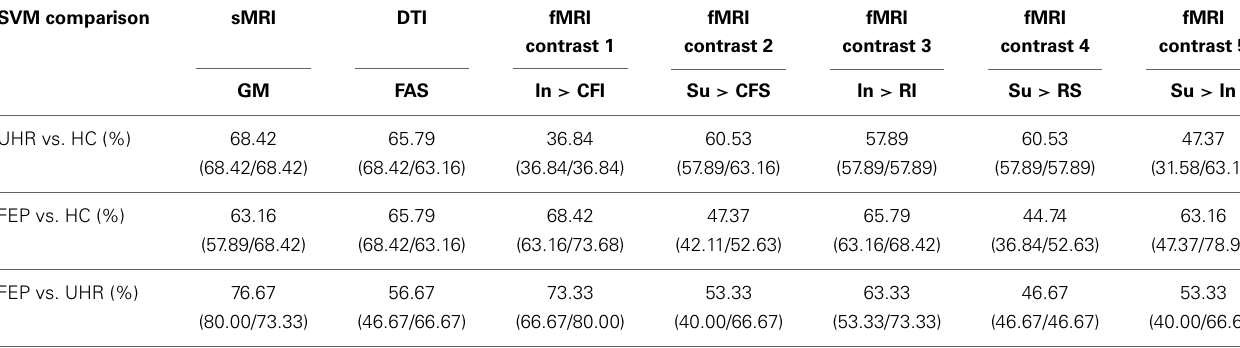
Table 1 | SVM classification accuracies using single modality data for each diagnostic comparison. SVM